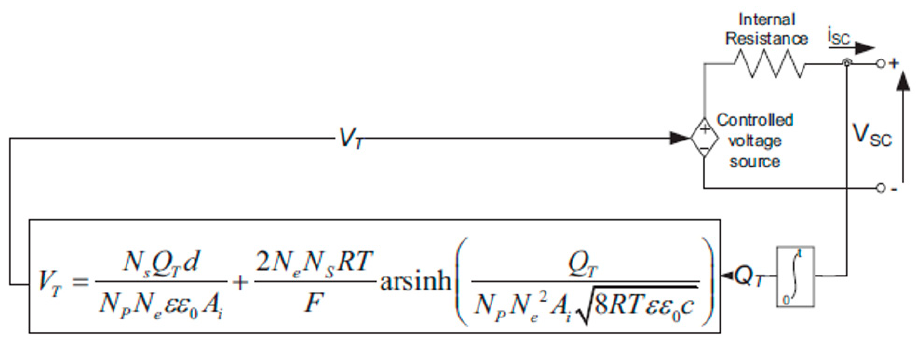
Figure 5. Supercapacitor equivalent circuit model.